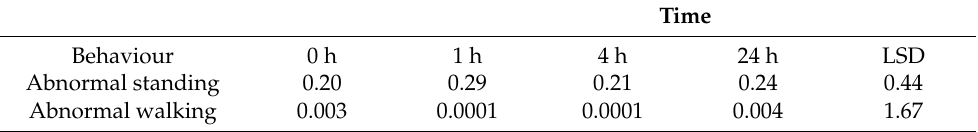
Table 7. Table of back-transformed predicted means for significant effects of time, with the least significant difference presented. Treatment groups are as follows: castration + analgesia (CML), castration (C), and sham control (SC).